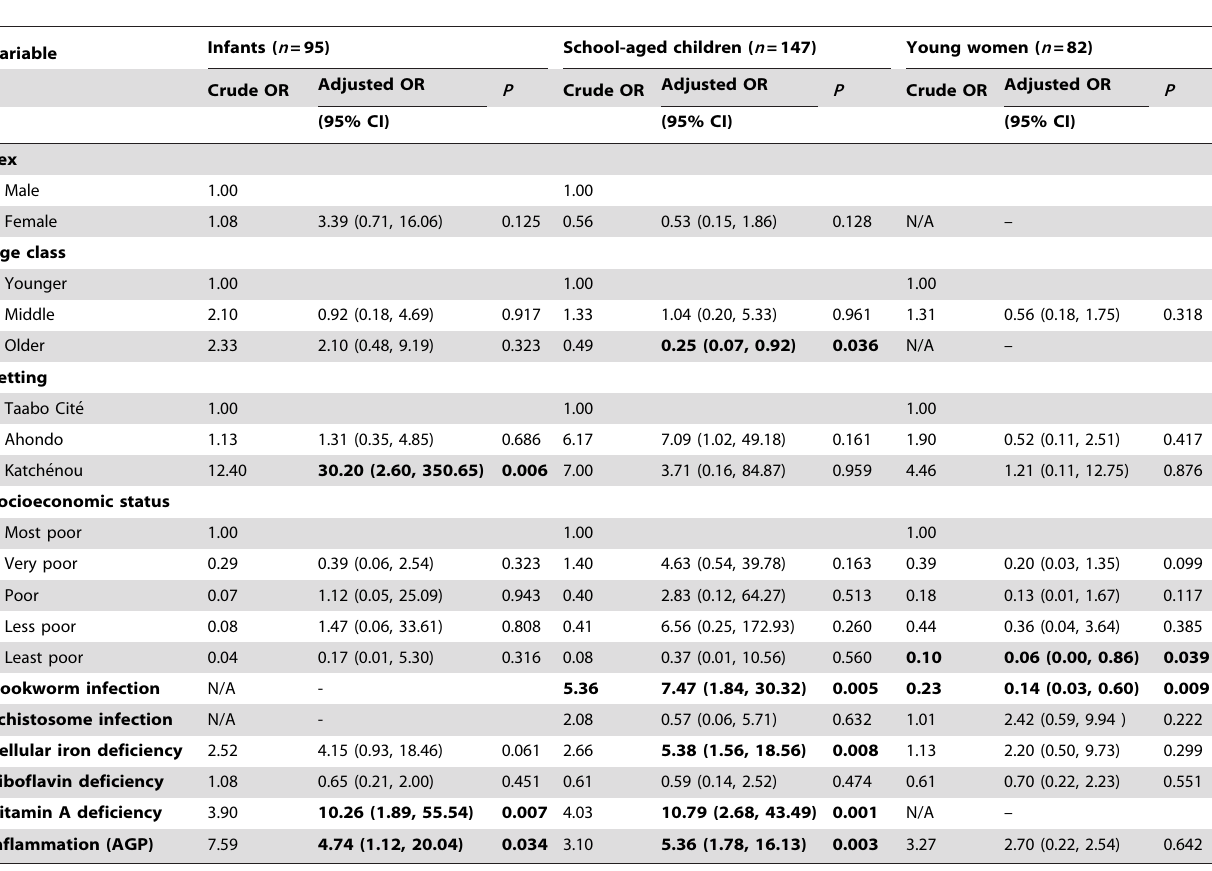
Table 2. Demographic, socioeconomic, parasitological, and micronutrient variables associated with P. falciparum infection, stratified by study